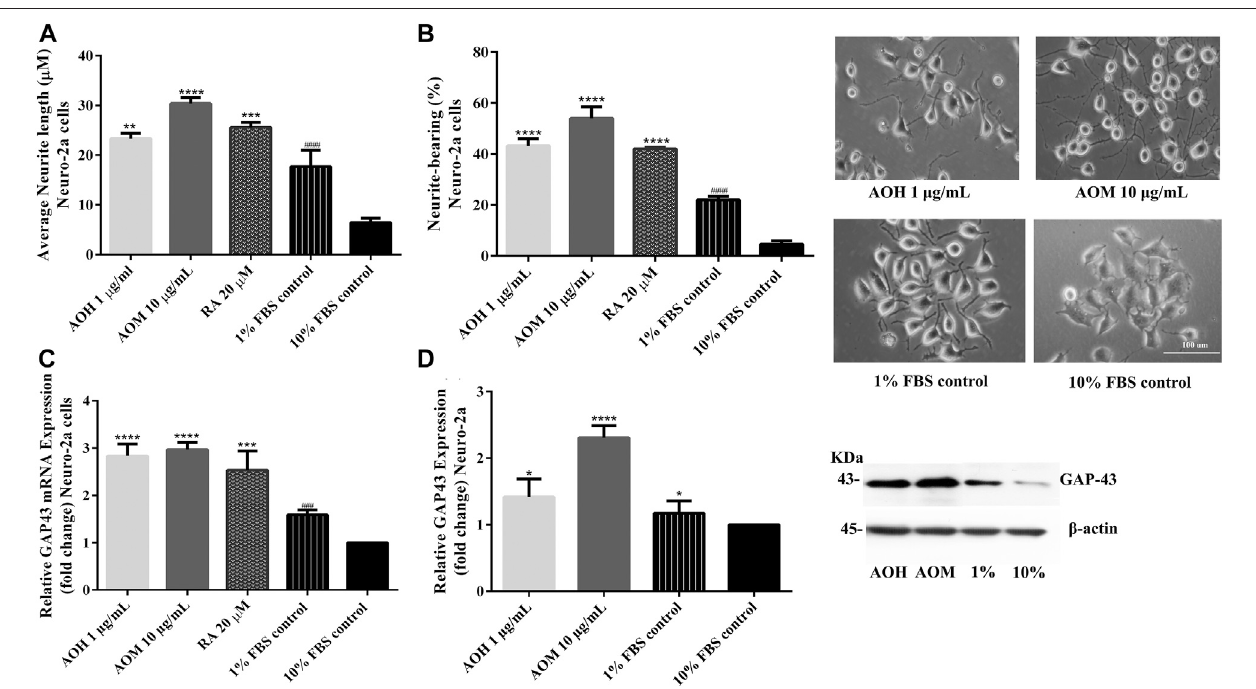
FIGURE 7 | Effect of AO extracts on neurite outgrowth. AO extract treatment increased the average of neurite lengths (A) and the percentage of neurite-bearing cells (B) inNeuro-2acells.CellmorphologyofNeuro-2acellswasobservedunderamicroscopeat10 × magni fi cation.RelativeexpressionlevelsofmRNA (C) andprotein (D) GAP-43 in Neuro-2a cells. Samples were treated with AO extracts for 48 h. Whole-cell lysates were subjected to western blot analysis of the GAP43 level after AO extract treatment. β -actin was used as an endogenous loading control for western blot assay and internal control for RT-PCR assay. All data were normalized to 10% FBS control level and the results are expressed as the means ± SEM of independent experiments ( n (cid:1) 3). * p < 0.05, ** p < 0.01, *** p < 0.001 and **** p < 0.0001 compared to the 1% FBS control; ### p < 0.001 and #### p < 0.0001 compared to the 10% FBS control.